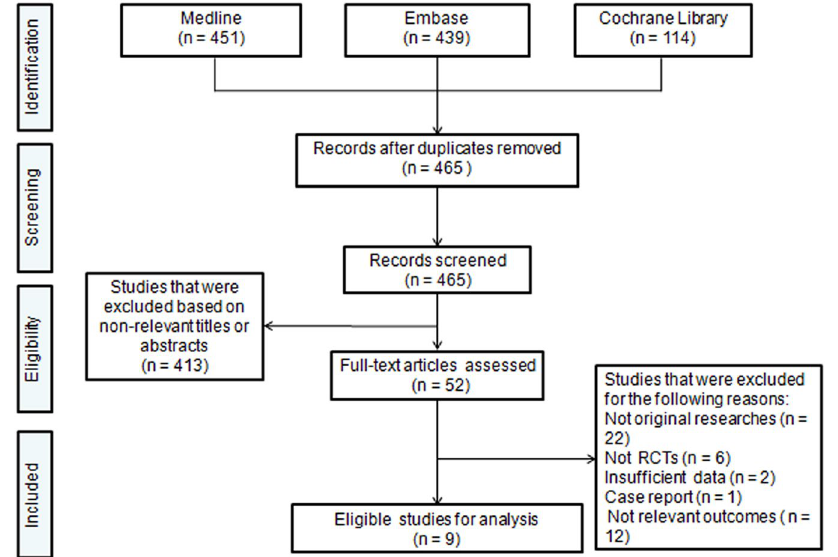
Figure 1. Flowchart of the literature search